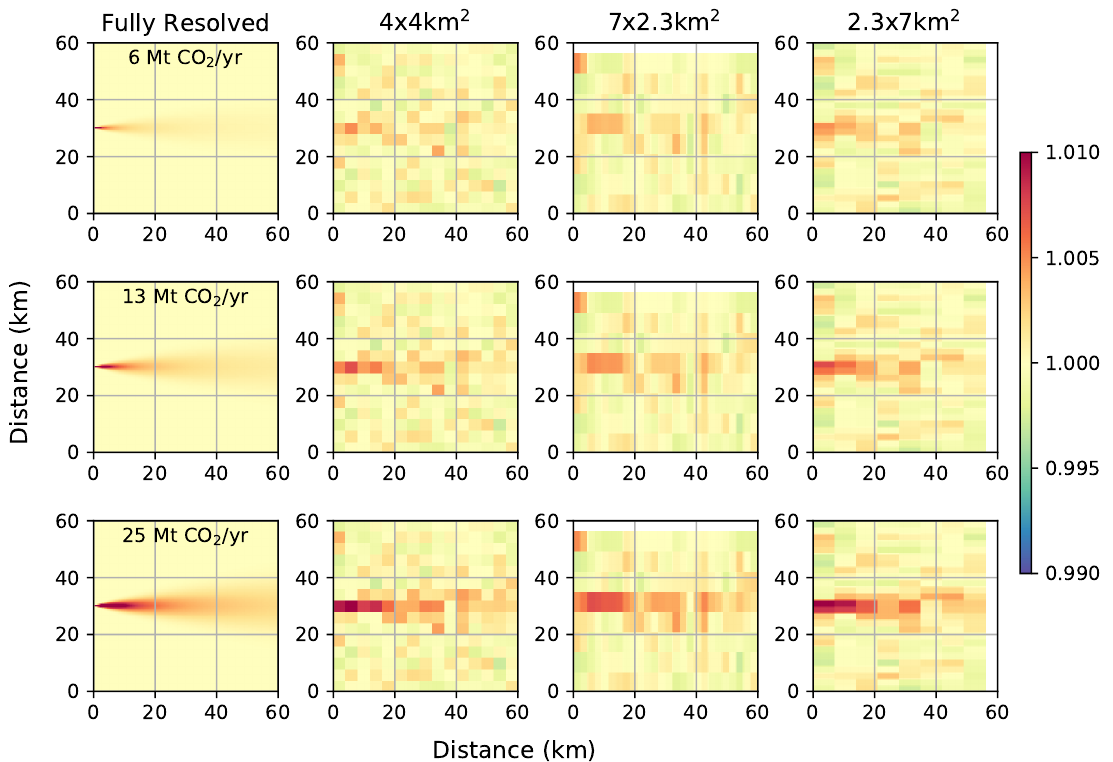
Figure 2. Simulated and noisy XCO 2 observations relative to a constant 400 ppm background as in Figure 1. Column 2 shows the noisy observations for square 4 × 4 km 2 pixels. Columns 3 and 4 show the noisy observations for rectangular 7 × 2.3 km 2 pixels with the long side oriented across the plume (column 3) and along the plume (column